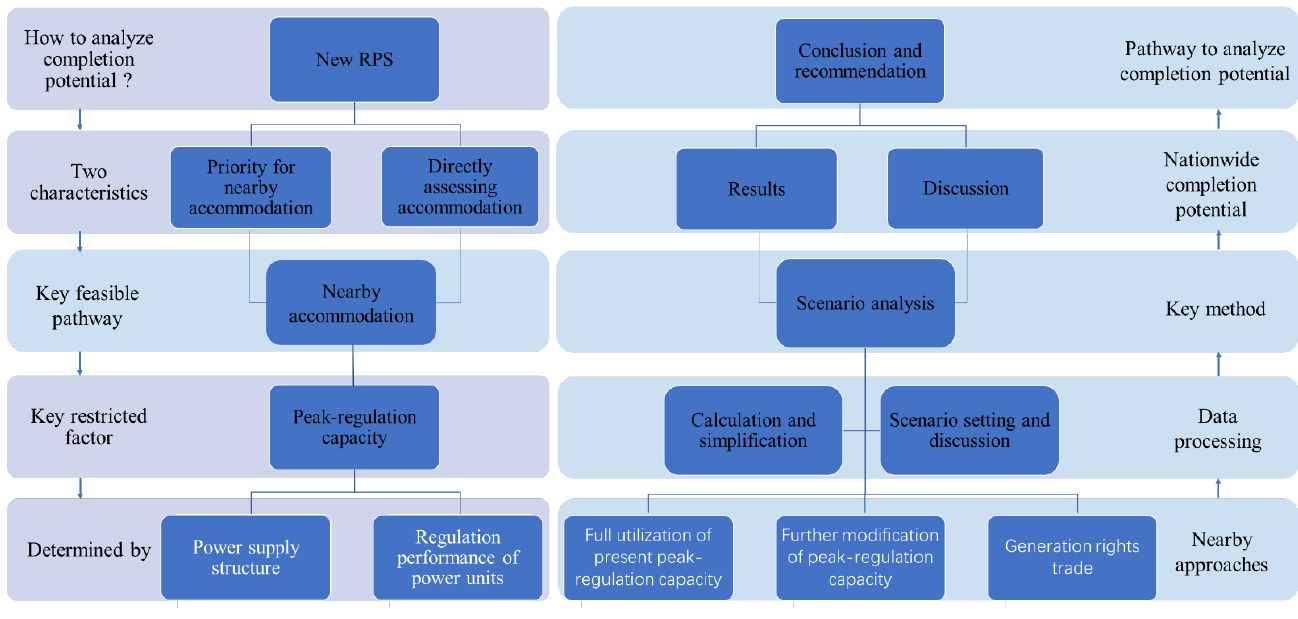
Figure 1. Framework of this paper.